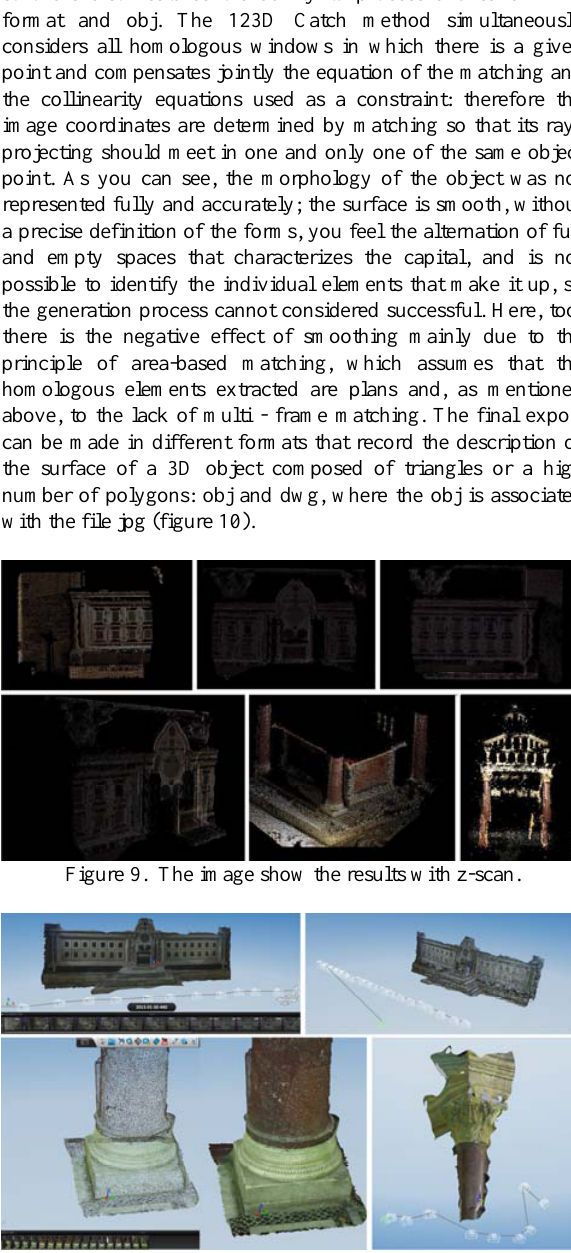
Figure 10. The image show the results with 123D